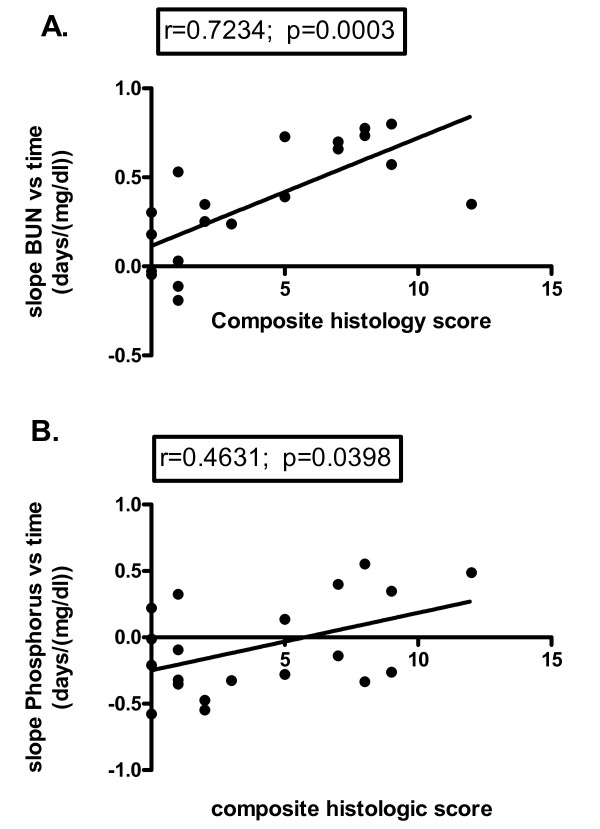
Correlation of BUN and phosphorus slope with composite ART nephropathy score. Correlation of BUN (r = 0.7234; p = 0.0003) and phosphorus (r = 0.4631; p = 0.0398) slope with composite ART nephropathy score reveals statistical significance. Black dots represent individual animals.